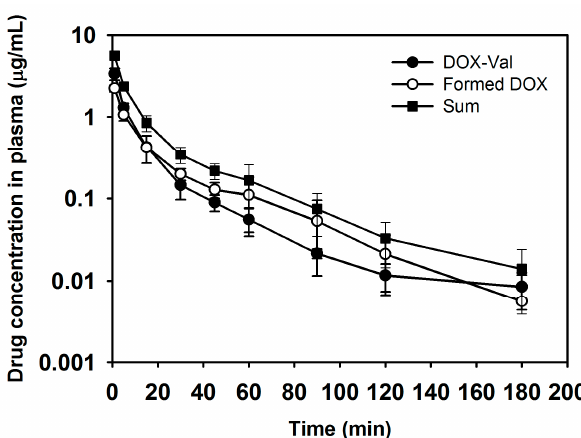
Figure 4. Pharmacokinetic study of DOX-Val (prodrug) after its intravenous administration in rats. DOX-Val (prodrug; ● ), formed DOX (metabolite; ○ ), and the sum of DOX-Val and formed DOX ( ■ ) concentrations in plasma according to the time are plotted. Dose of DOX-Val was 4 mg/kg. Data are presented as means ± standard deviation ( n = 4). Table 1. Pharmacokinetic parameters of DOX-Val (prodrug), formed DOX (metabolite), and sum in rats after intravenous bolus administration of DOX-Val ( n = 4).